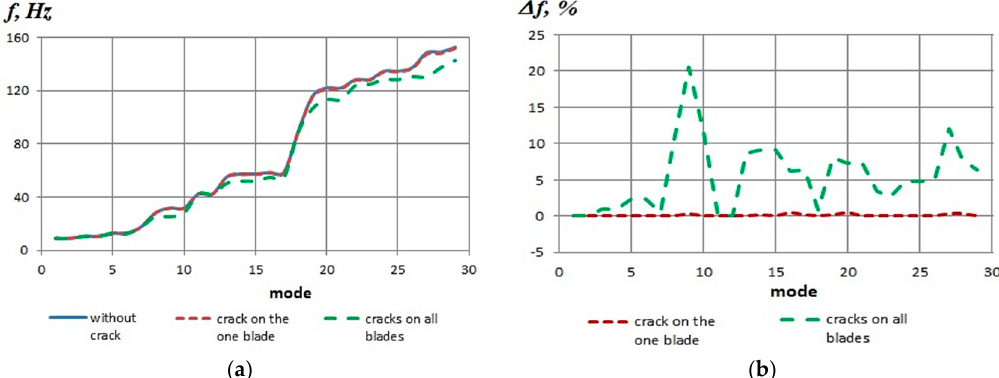
Figure 4. The influence of cracks on the eigenfrequencies of the unit: ( a ) change in absolute values; ( b ) change in relative values.